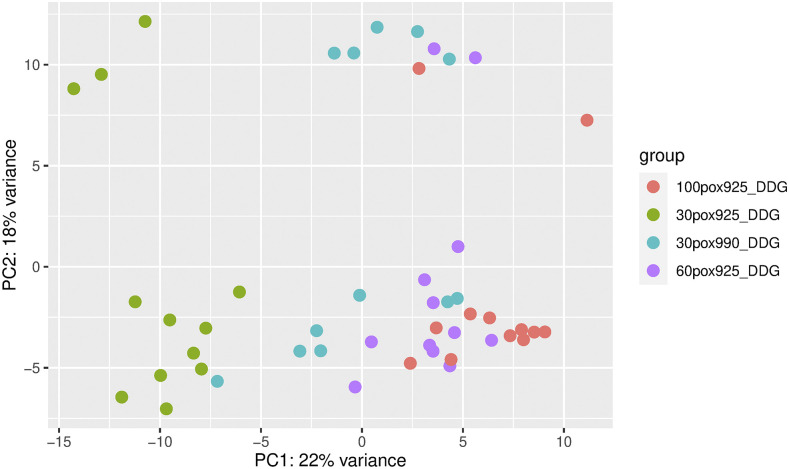
Principal component analysis of treatment at the stages of development sampled.